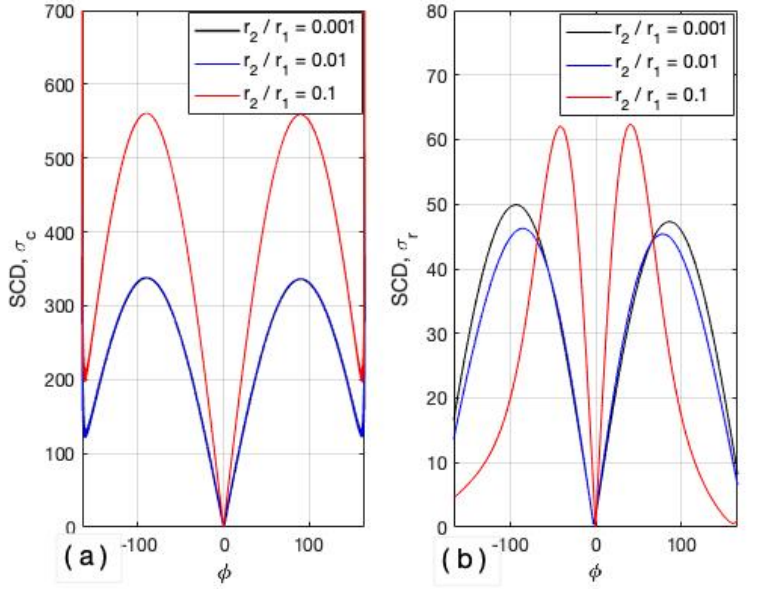
Figure 7. Surface current density (SCD) at the resonant excitation of the TM s 11 complex eigenmode over: ( a ) the cavity surface ( − 165 ◦ ≤ φ ≤ 165 ◦ , φ 0 = π /12); ( b ) the rod surface ( − π ≤ φ ≤ π